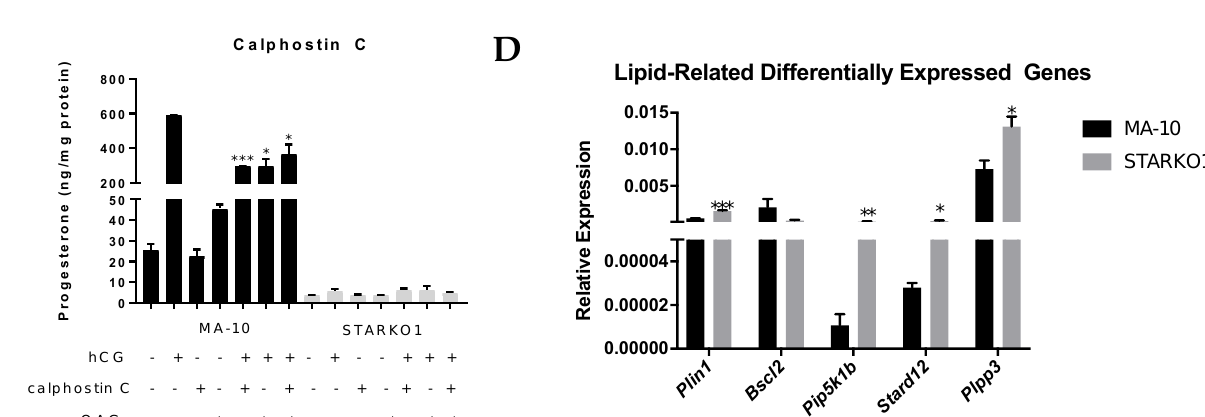
Figure 6. Role of DAG signaling in progesterone production by WT MA-10 and STARKO1 cells. ( A ) ELISA analyses of progesterone levels in cell media following treatment with varying concentrations of the DAG analog OAG in the absence (left) and presence (right) of 50 ng/mL hCG for 2 h. ( B ) ELISA analyses of progesterone levels in cell media following treatment with varying concentrations of PLC inhibitor U73122 in the absence (left) and presence (right) of 50 ng/mL hCG for 2 h. ( C ) ELISA analyses of progesterone levels in cell media following treatment with 1 μM of PKC inhi bitor calphostin C in combination with 50 ng/mL hCG and/or 50 μM OAG for 2 h. ( D ) qRT-PCR analyses of lipid-related differentially expressed genes. Data are shown as the mean ± SEM ( n = 3). * p < 0.05; ** p < 0.01; *** p < 0.001.